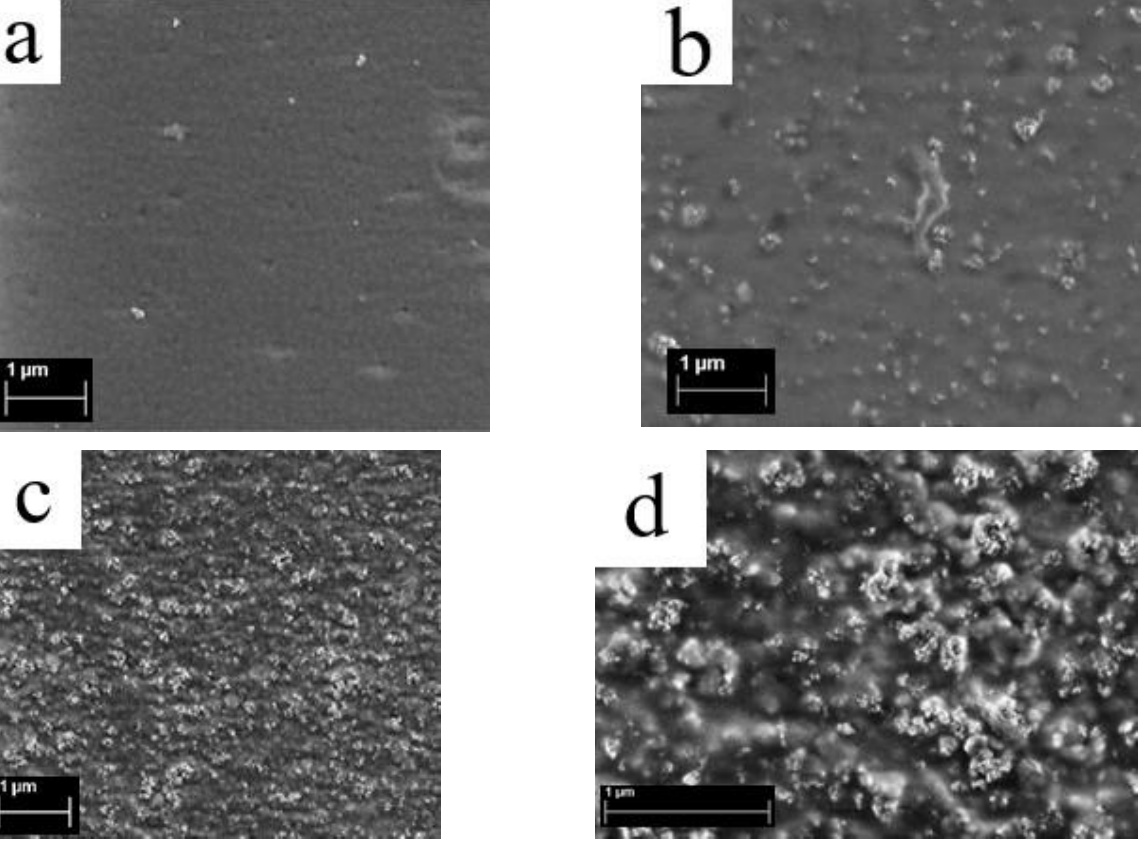
Figure 3. SEM images of the Aquivion ® -type membranes (EW = 890 g-eq/mol) with DND Z+: ( a ) 0% DND (without nanodiamonds); ( b ) 0.5 wt.% DND; and ( c , d ) 5 wt.% DND (different scales).